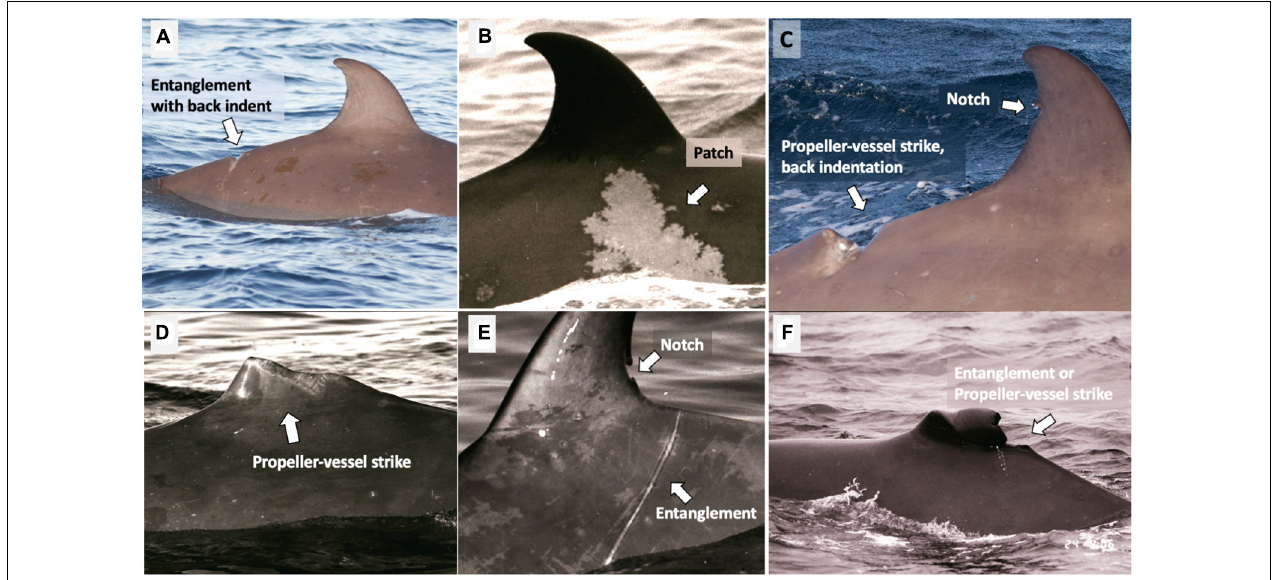
FIGURE 5 | Examples of mark types and keywords, as annotated on dorsal fins of northern bottlenose whales. Alternative keywords are provided in parentheses. (A) Back indent, entanglement; (B) patch (large body scar); (C) propeller-vessel strike, back indentation, notch (large body scar); (D) propeller-vessel strike (large fin scar); (E) notch, entanglement (large body scar); (F) entanglement, propeller-vessel strike (large fin